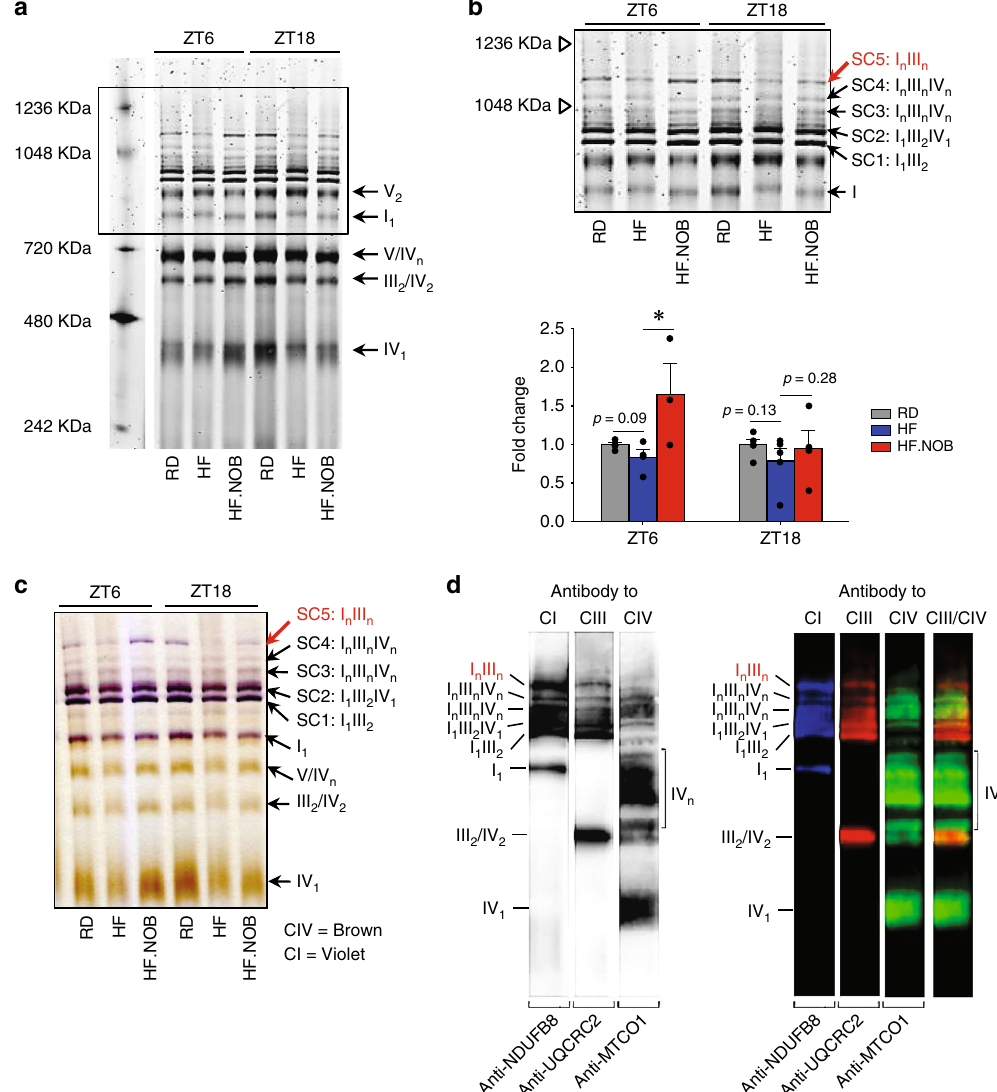
Fig. 7 NOB restored mitochondrial supercomplex formation affected by HF feeding. Aged mice were fed with regular diet (RD), high-fat (HF) diet, or HF diet with NOB (HF.NOB). a Mitochondrial OXPHOS supercomplexes (SCs) analyzed by BN-PAGE. Representative BN-PAGE of digitonin-solubilized mitochondria puri fi ed from skeletal muscle of RD, HF, and HF-NOB-treated mice is shown. b Upper panel: enlarged view of the box area from a . Lower panel: quanti fi cation of SC5 band intensities (ZT6, n = 4, 4, and 3 for RD, HF, and HF.NOB, respectively; ZT18, n = 5, 5, and 4 for RD, HF, and HF.NOB, respectively). c In-gel activity assay with Complex IV and subsequently with Complex I substrates performed as described in Methods. Brown and violet color bands indicate CIV and CI activity, respectively. d Western blot analysis of the respiratory Complexes I, III and IV isolated from skeletal muscle mitochondria in aged mice. Western blotting was performed as described in Methods. Lane 1: antibody to CI subunit 8, pseudo-colored blue; lane 2: antibody to CIII, subunit 2 (QCR2, Cor2), pseudo-colored red; lane 3: antibody to CIV subunit I (Cox1), pseudo-colored green; lane 4: overlay of lanes 2